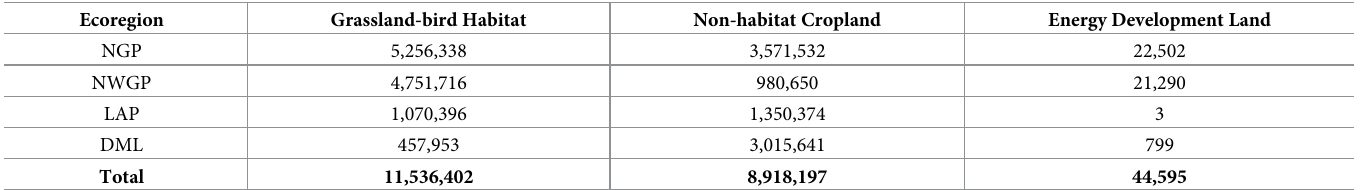
Table 2. Area (ha) of suitable (i.e., a relative habitat-quality ranking � 0.3 out of a maximum value of 1.0) grassland-bird habitat and of non-suitable habitat that was devoted to cropland and energy development in 2014 within the Northern Glaciated Plains (NGP), Northwestern Glaciated Plains (NWGP), Lake Agassiz Plain (LAP), and Des Moines Lobe (DML) ecoregions of the United States. Areas were quantified using the National Agricultural Statistics Service Cropland Data Layer.